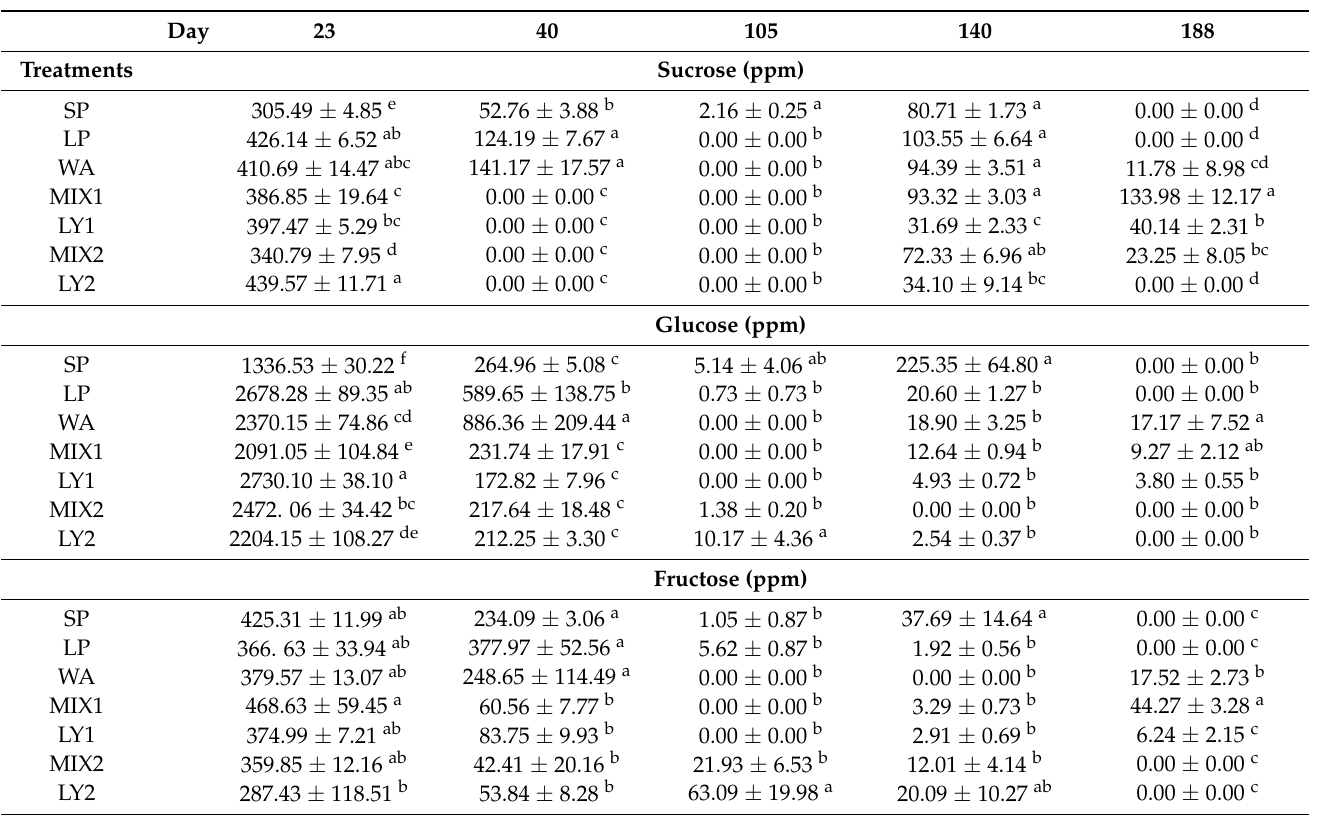
Table 2. Change in concentrations of sugars in the pulp of Leccino olives during spontaneous (SP) or starter-driven fermentation, measured by HPLC analysis. Different letters indicate significant differences among the different treatments ( p ≤ 0.05) at the same sampling time. Data are averaged from the three replicates ± standard error.